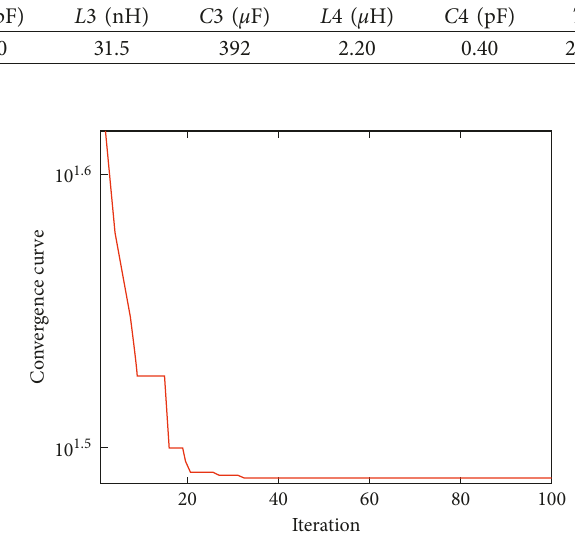
Figure 16: The convergence curve of objective